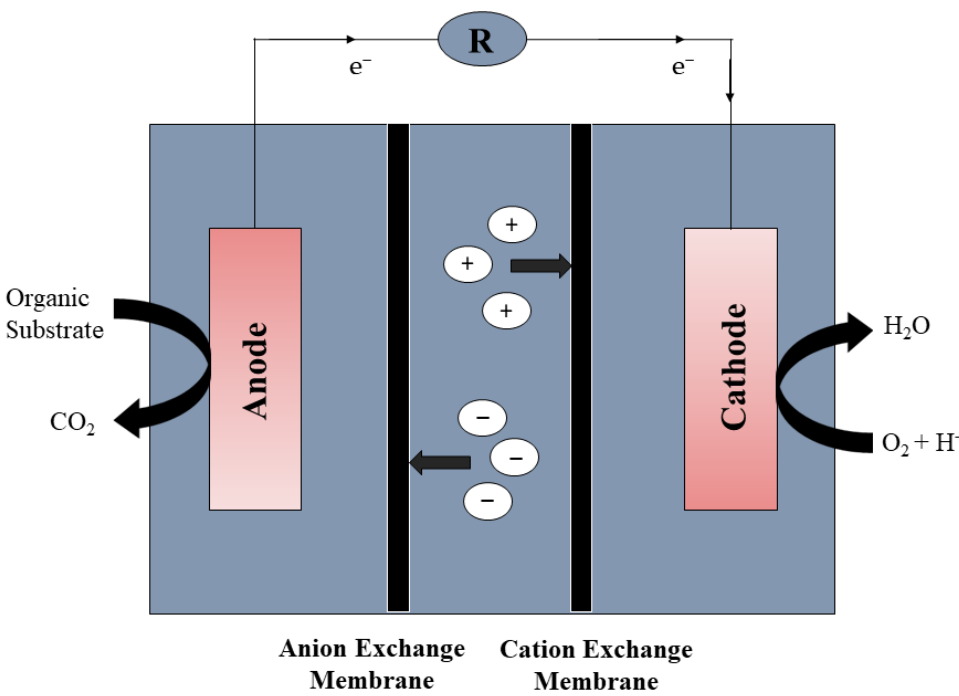
Figure 5. General representation of MDC-MFCs.